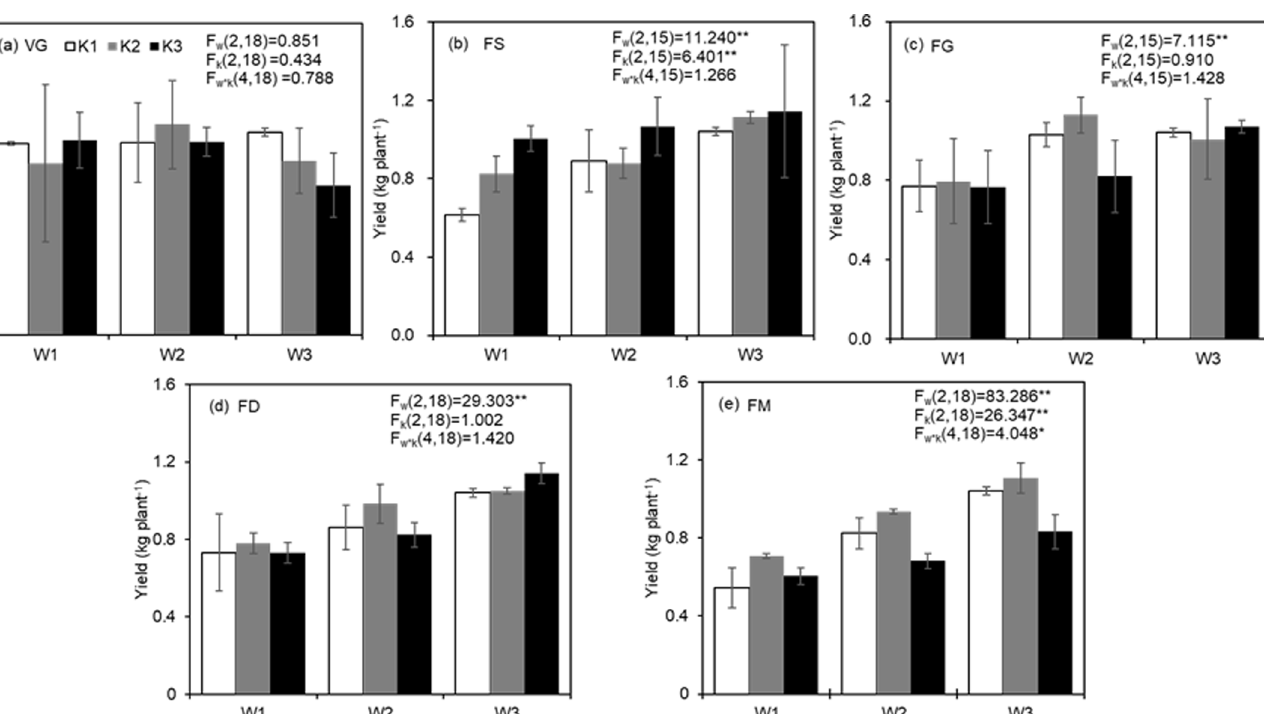
, 70–80% θ and 80–90% θ , f f f